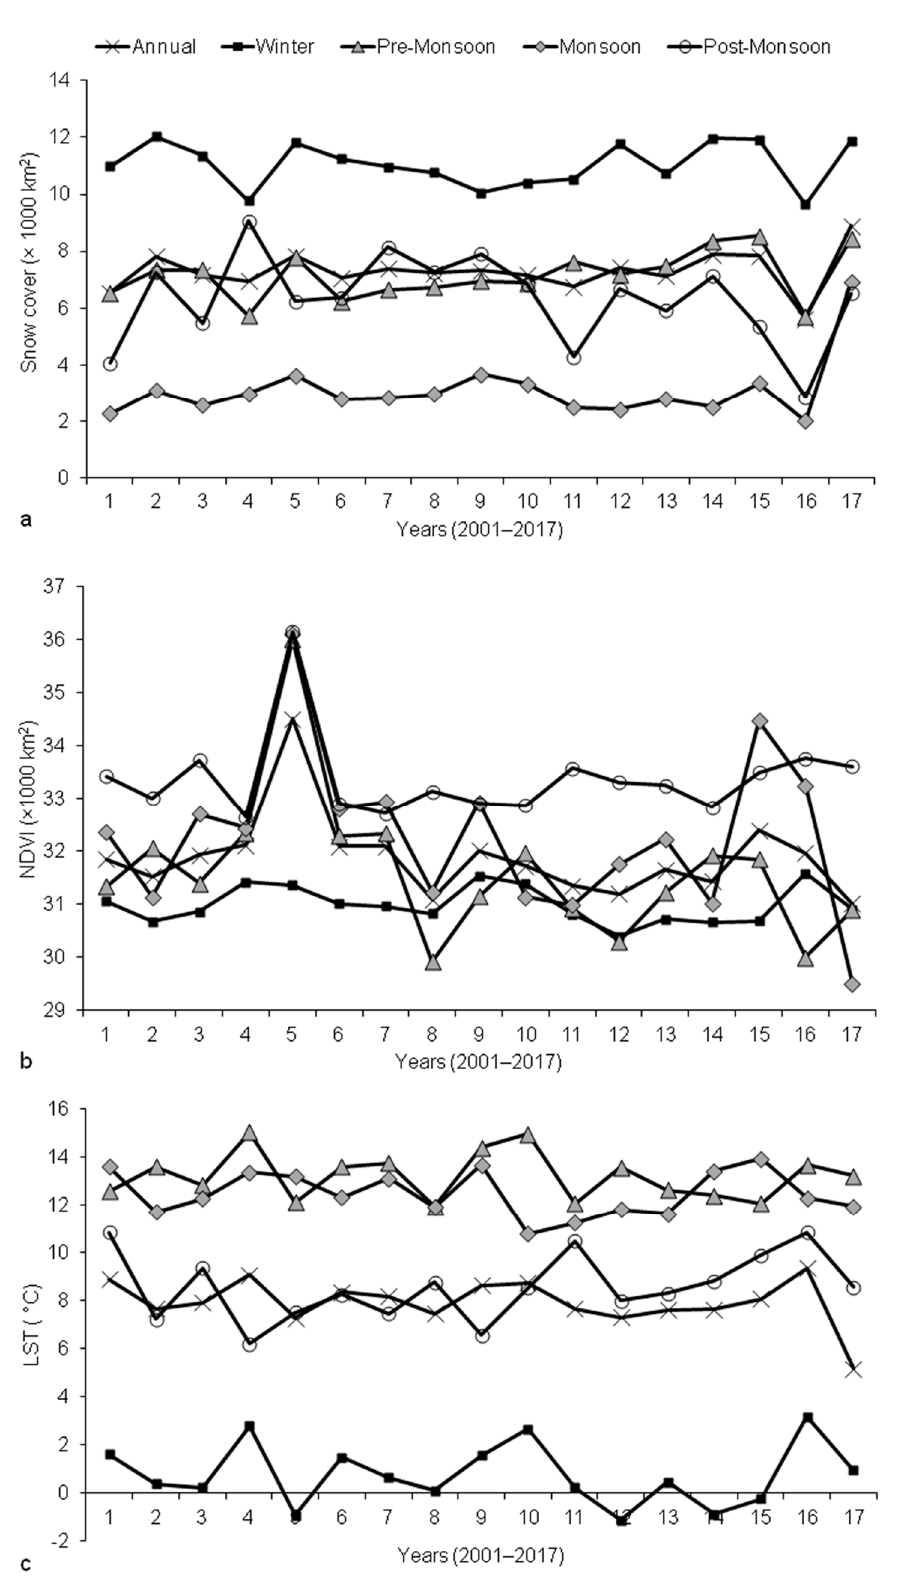
Figure 7. Changes in ( a ) snow cover, ( b ) vegetation covers with NDVI ≥ 0.3 and ( c ) average temperature occurring annually and in different seasons in Uttarakhand.